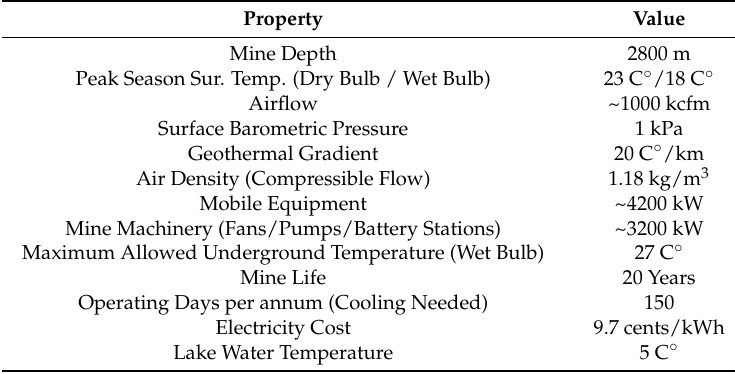
Table 3. Properties of the selected mining